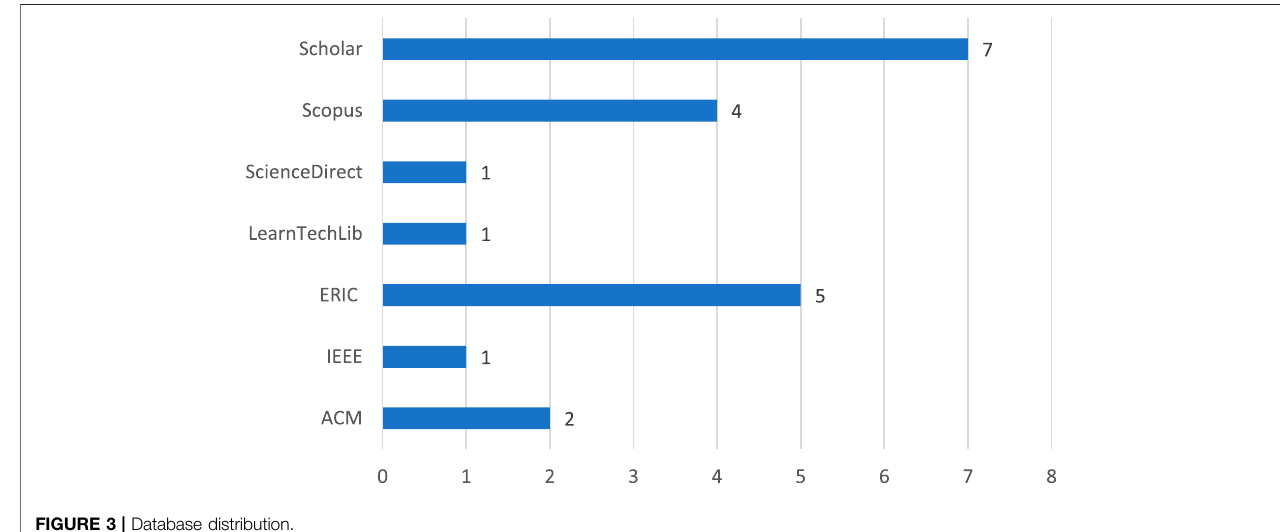
FIGURE 3 | Database